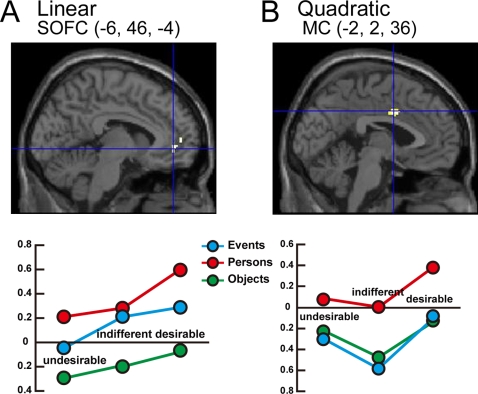
Locations shown in sagittal section and parameter estimates showing modulation by desirability rating (A) linear (1st order) relationship in SOFC at −6, 46, −4, (B) quadratic (2nd order) relationship in MC at −2, 2, 36.